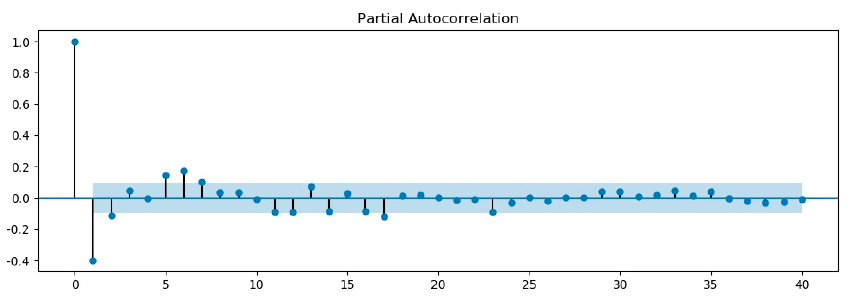
Figure 7. PACF diagram after first difference.